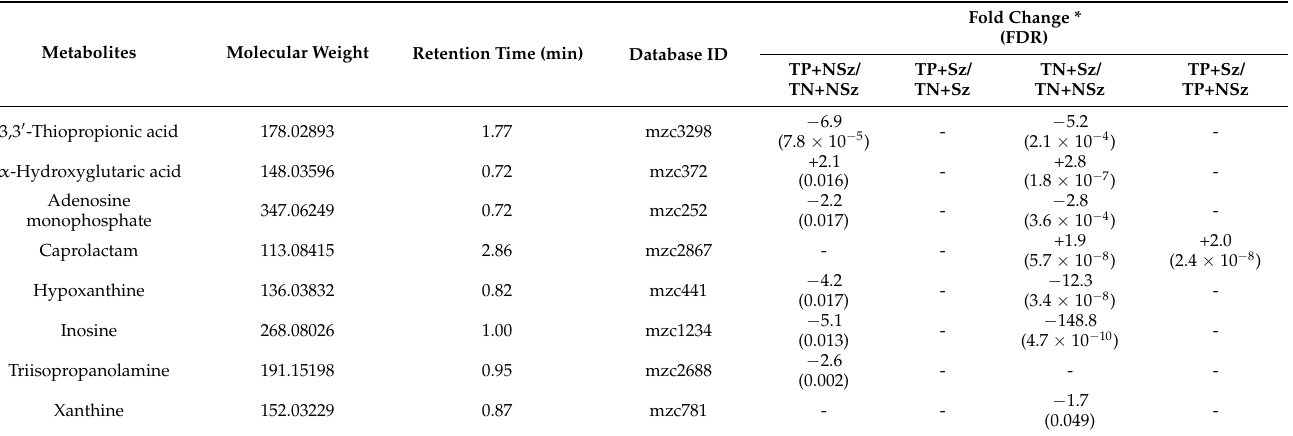
Table 3. List of DeMFs in different group